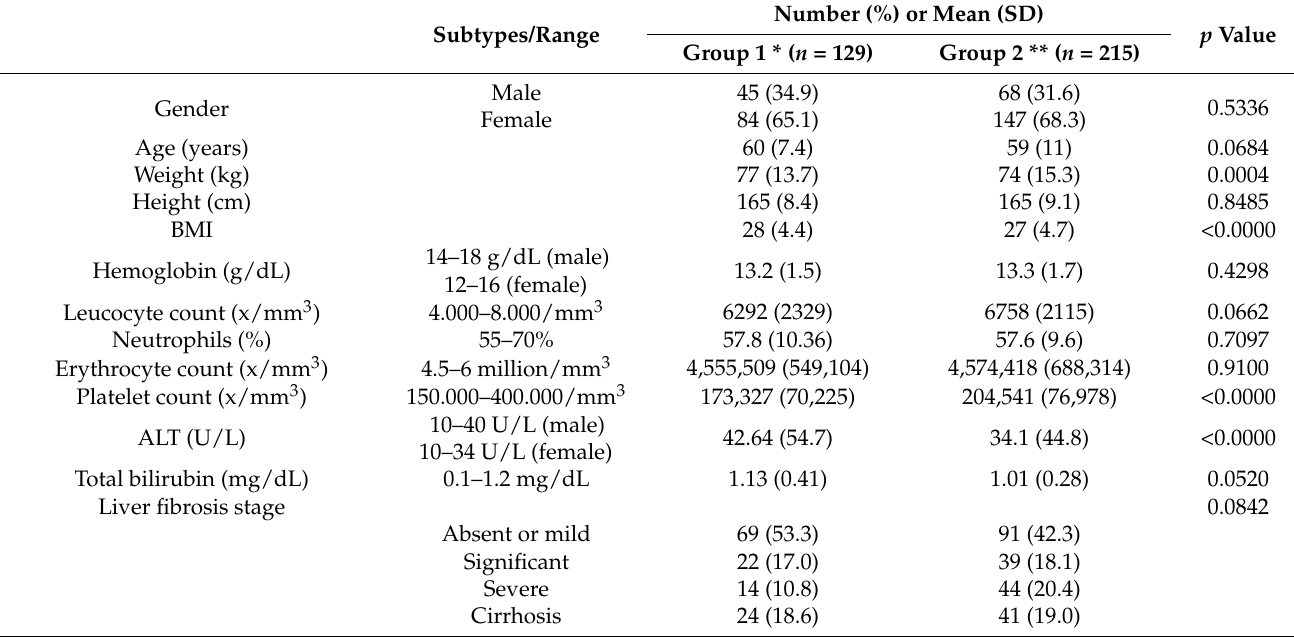
Table 1. Study sample’s general characteristics, with demographics and average laboratory values recorded from the study participants. Data in this table were collected at 12 weeks, split by treatment options, and compare means and proportions between the two study